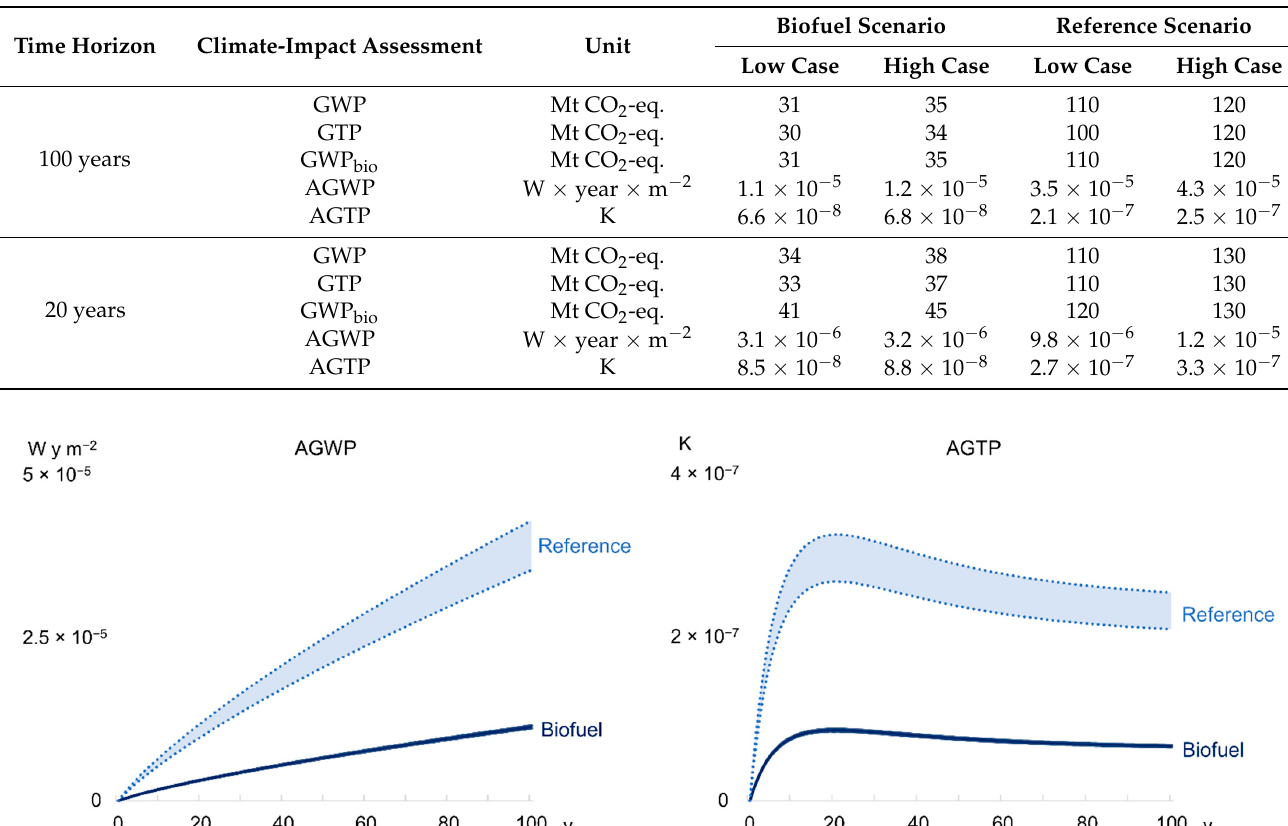
Figure 5. Climate impact in terms of AGWP (left) and AGTP (right) resulting from the handling of wheat straw in the biofuel scenario and the reference scenario. The climate impact is calculated for utilization of 200,000 t DM straw.